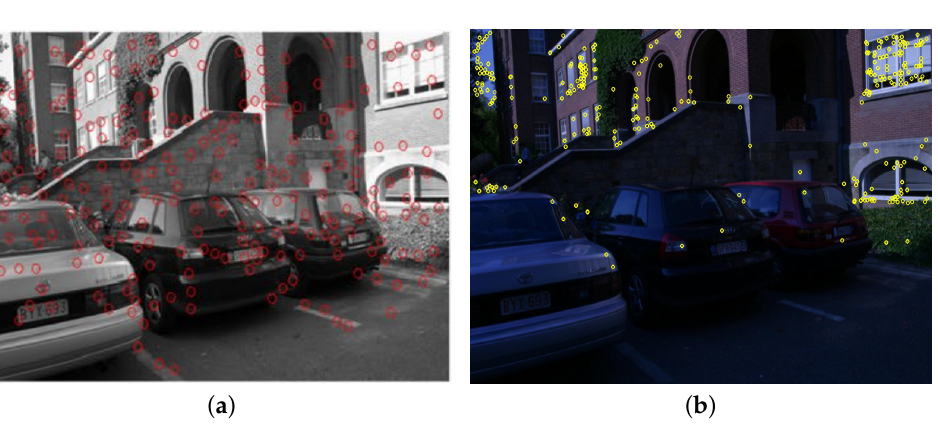
Figure 18. The extraction result of feature points of the reference image. ( a ) the adaptive RKEM algorithm; ( b ) the algorithm in this paper.